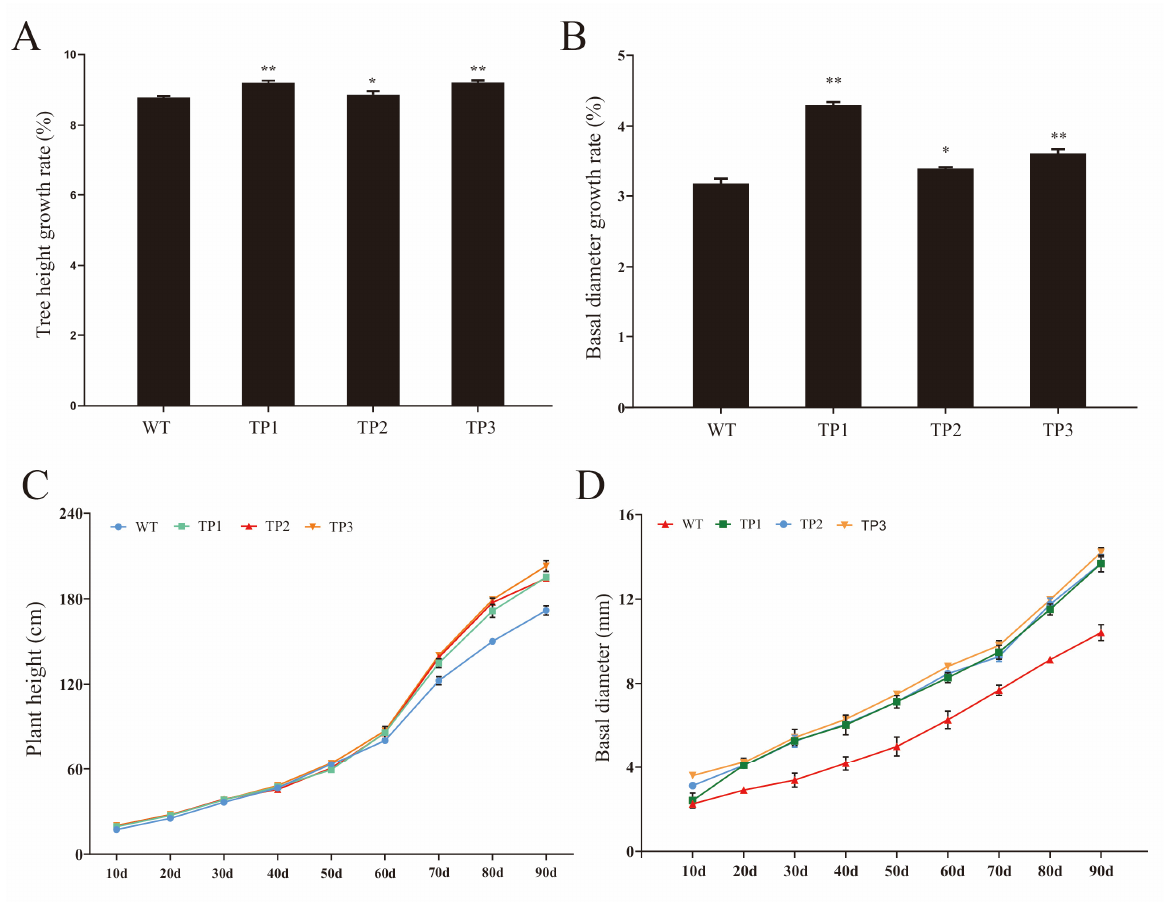
Figure 3. Overexpression of OsCYP85A1 in poplar increases plant height and stem diameter. ( A ) Tree height growth rate. ( B ) Basal diameter growth rate. ( C ) Plant height. ( D ) Basal diameter. Error bars represent the SDs from three biological replicates. * and ** indicate significant differences in comparison to WT at p < 0.05 and p < 0.01, respectively (Student’s t -test).